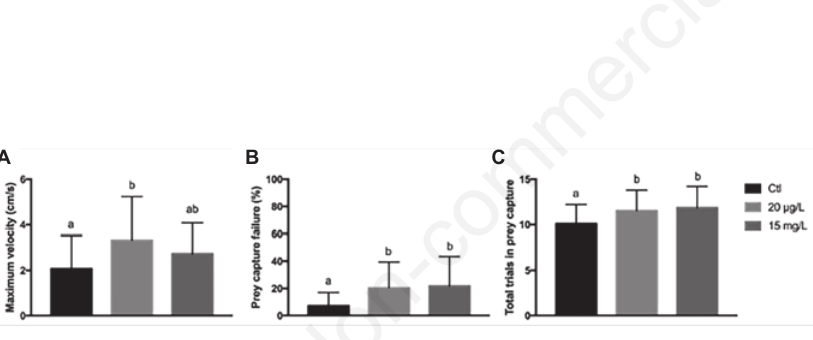
Figure 1. Immediate effects of 7 days b -N-methylamino-L-alanine (BMAA) exposure on newly hatched rivulus larvae behaviors. A) A significant effect at 20 µg/L BMAA was